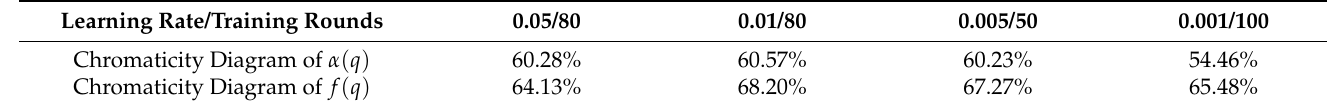
Table 1. Input the chromaticity diagram into the model and obtain the test set recognition rate under different training rounds and learning rates.